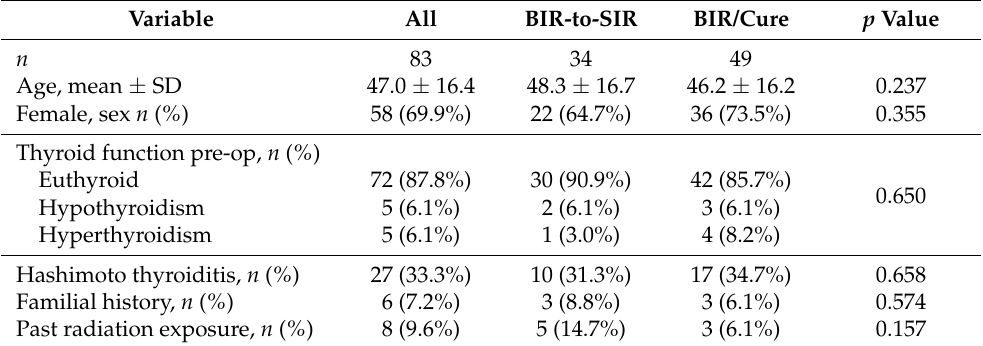
Table 1. Patient demographics and clinical